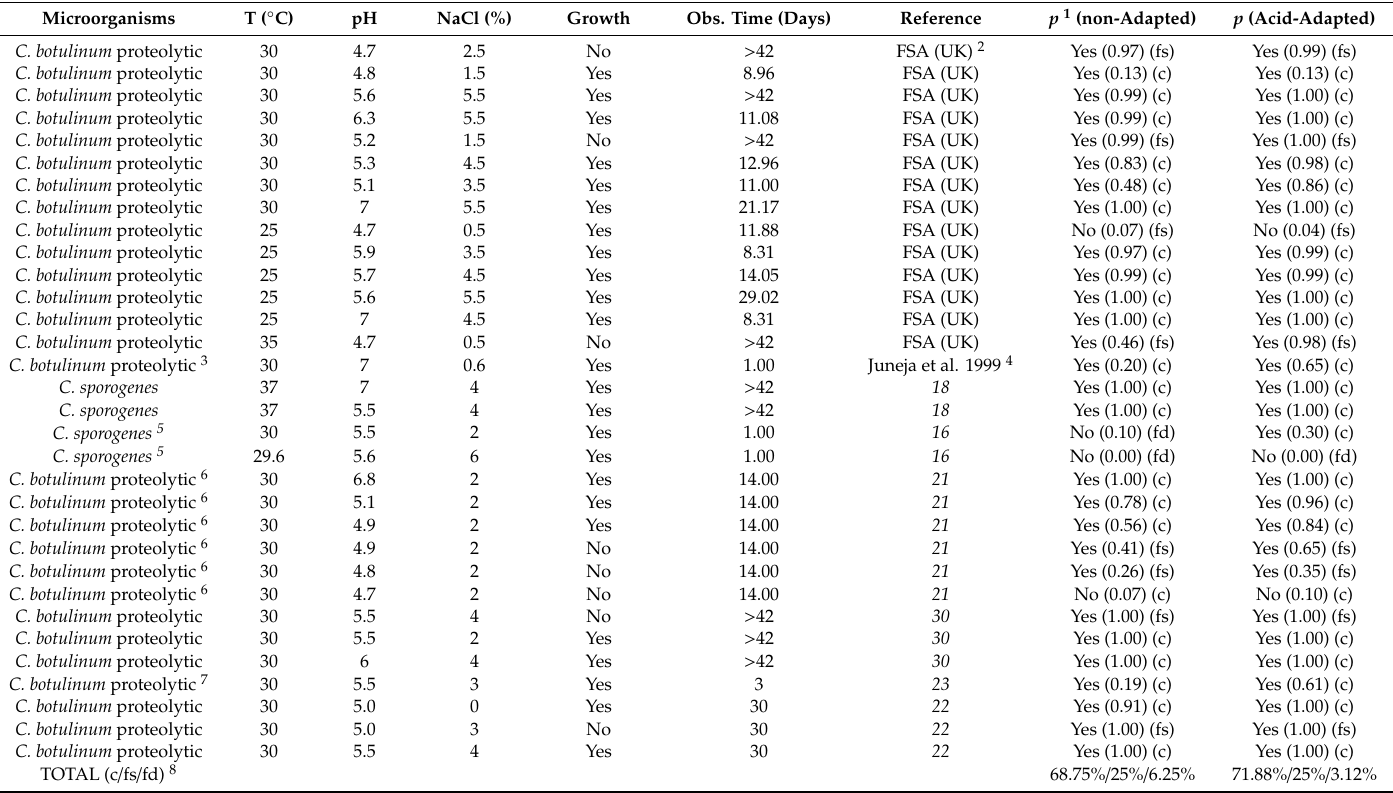
Table 7. Reported growth responses of C. botulinum and C. sporogenes strains in di ff erent published studies performed in culture media and their comparison with predictions of the probability of germination of the non-adapted and acid-adapted C. sporogenes strains used in the present